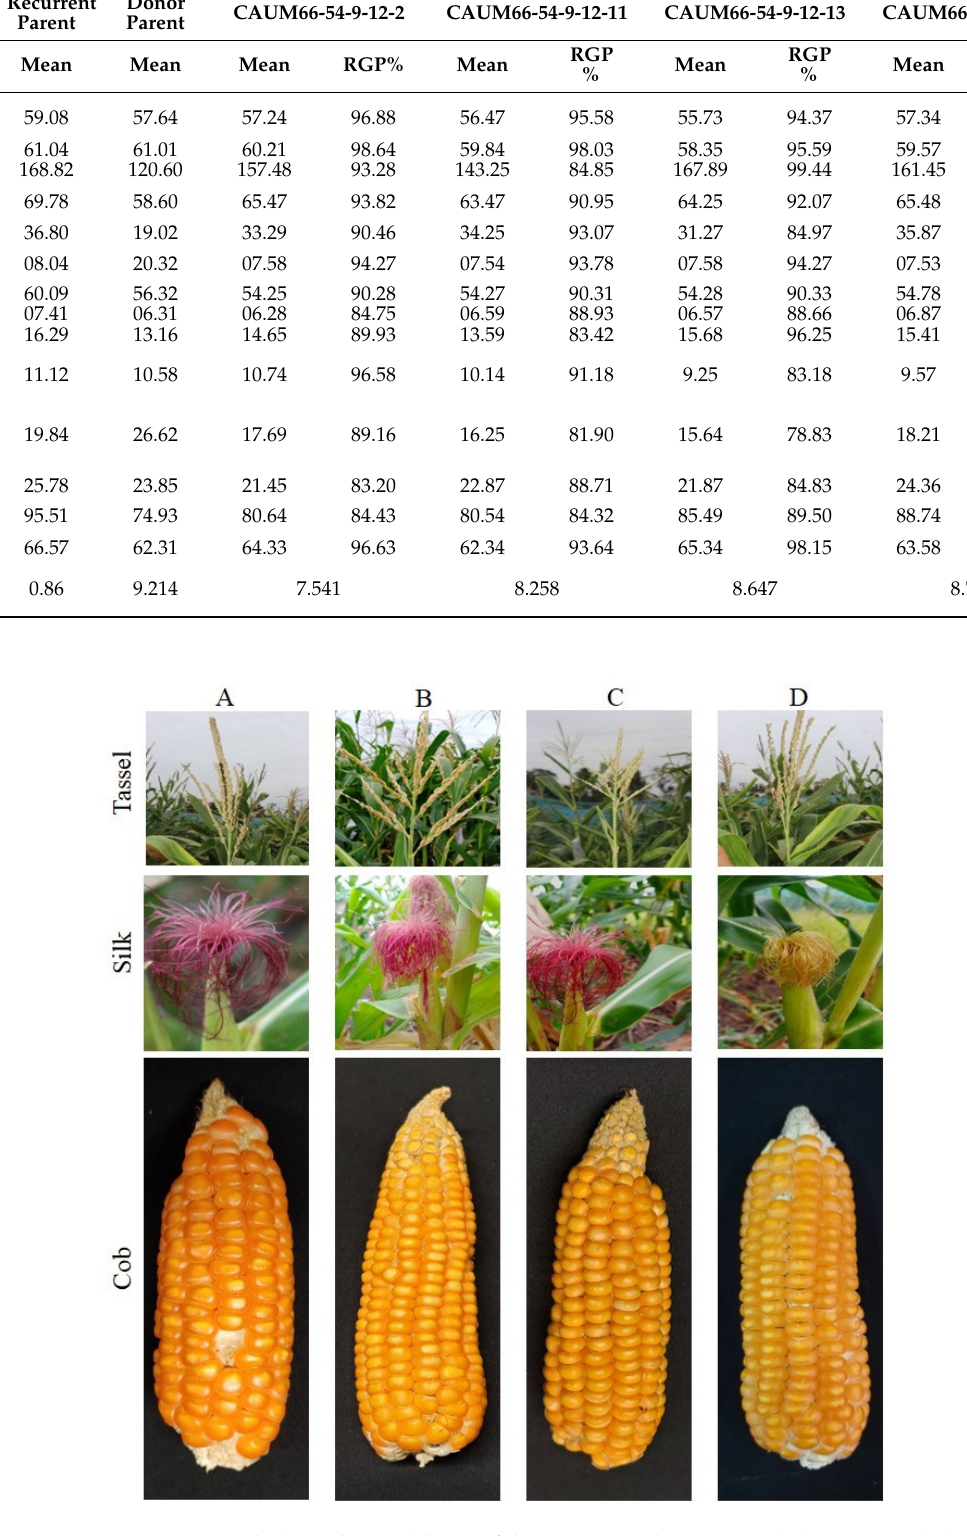
Figure 3. Morphological resemblance of the parents and progenies. ( A ) CAUM66; ( B ) CAUM-54-9- 12-24; ( C ) CAUM-54-9-12-13; ( D ) UMI285β + .